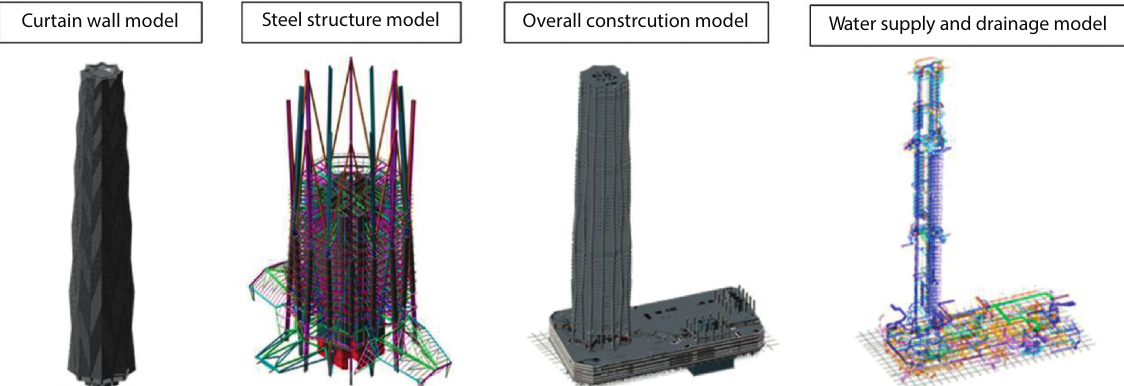
Figure 11: Submodels built in the 3D BIM platform.